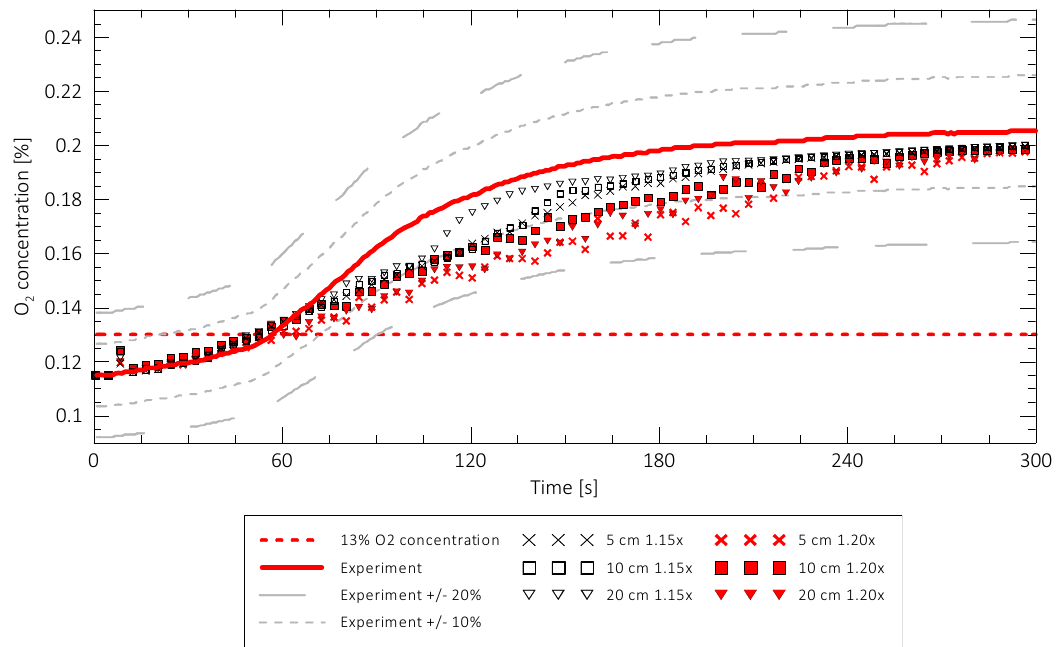
Figure 7. Results of mesh sensitivity study for Reynolds-Averaged Navier–Stokes (RANS) k- ε (Realizable) turbulence model and IG 55 mixture (50% Ar, 50% N 2 )—oxygen concentration (v/v) at lowest measuring element in the experiment and numerical study.